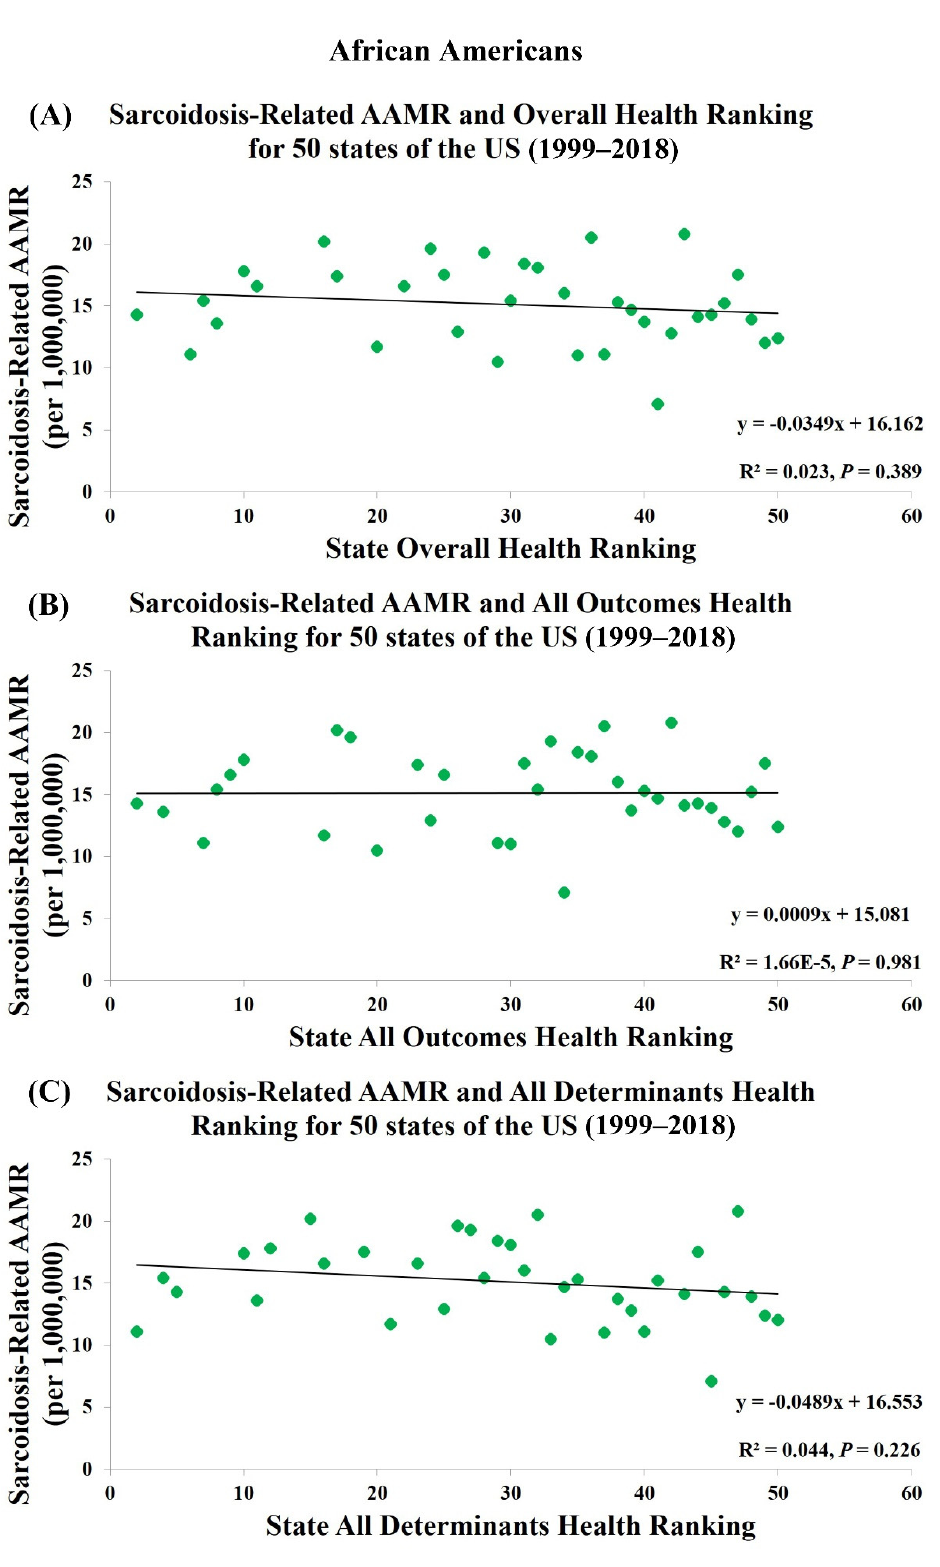
Figure 4. Sarcoidosis-Related AAMR in African Americans is not associated with ( A ) Overall Health Rankings, ( B ) All Outcomes Health Rankings, and ( C ) All Determinants Health Rankings.